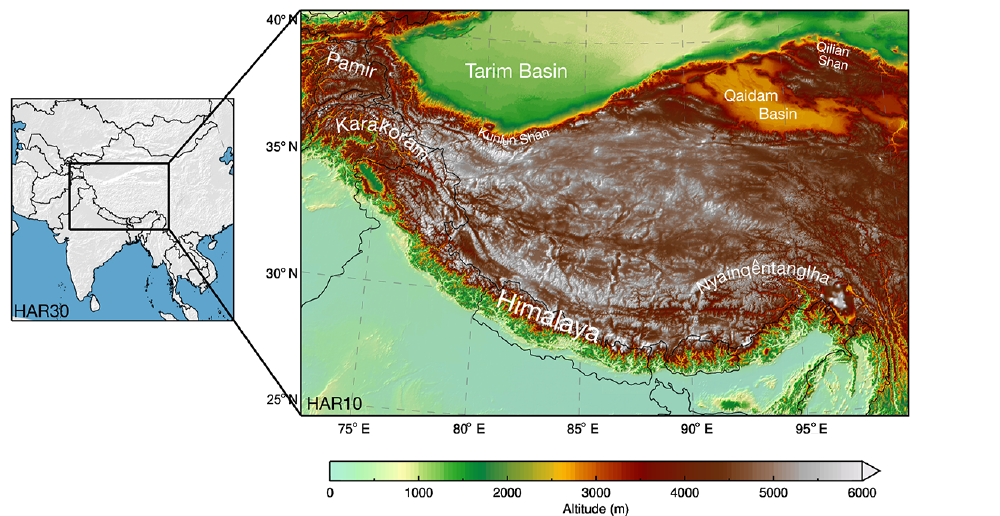
Figure 1. Map of the Weather and Research Forecasting (WRF) model domain HAR10 (high Asia domain) and its location nested in the larger domain HAR30 (south–central Asia domain). Geographical locations are indicated in